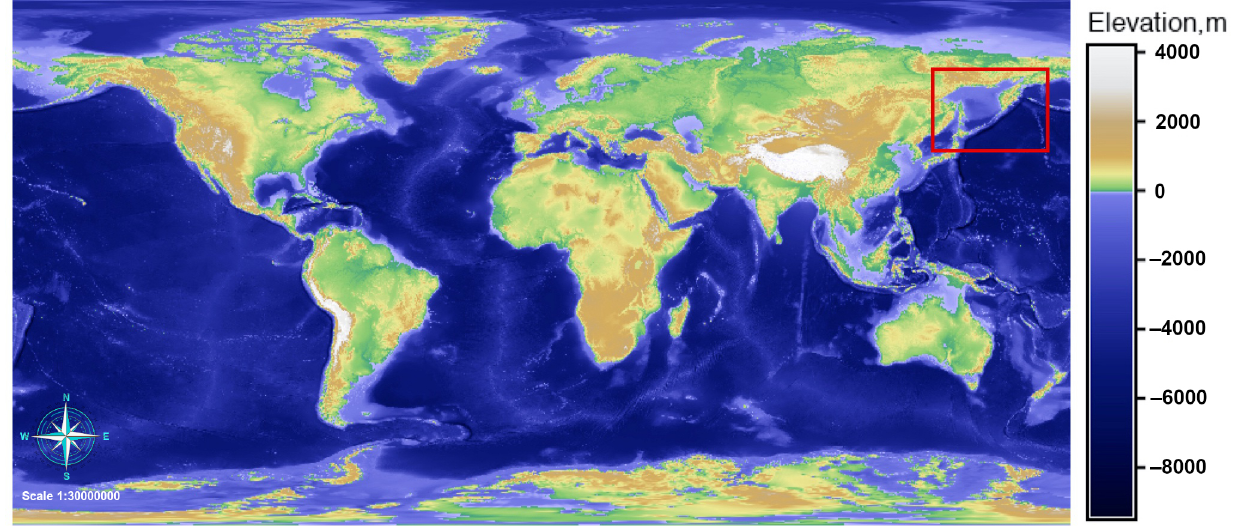
Figure 1. Study area on the Earth Global Relief Model (ETOPO1) GeoTIFF by National Oceanic and Atmospheric Administration (NOAA). Mapping: Geographic Resources Analysis Support System Geographic Information System (GRASS